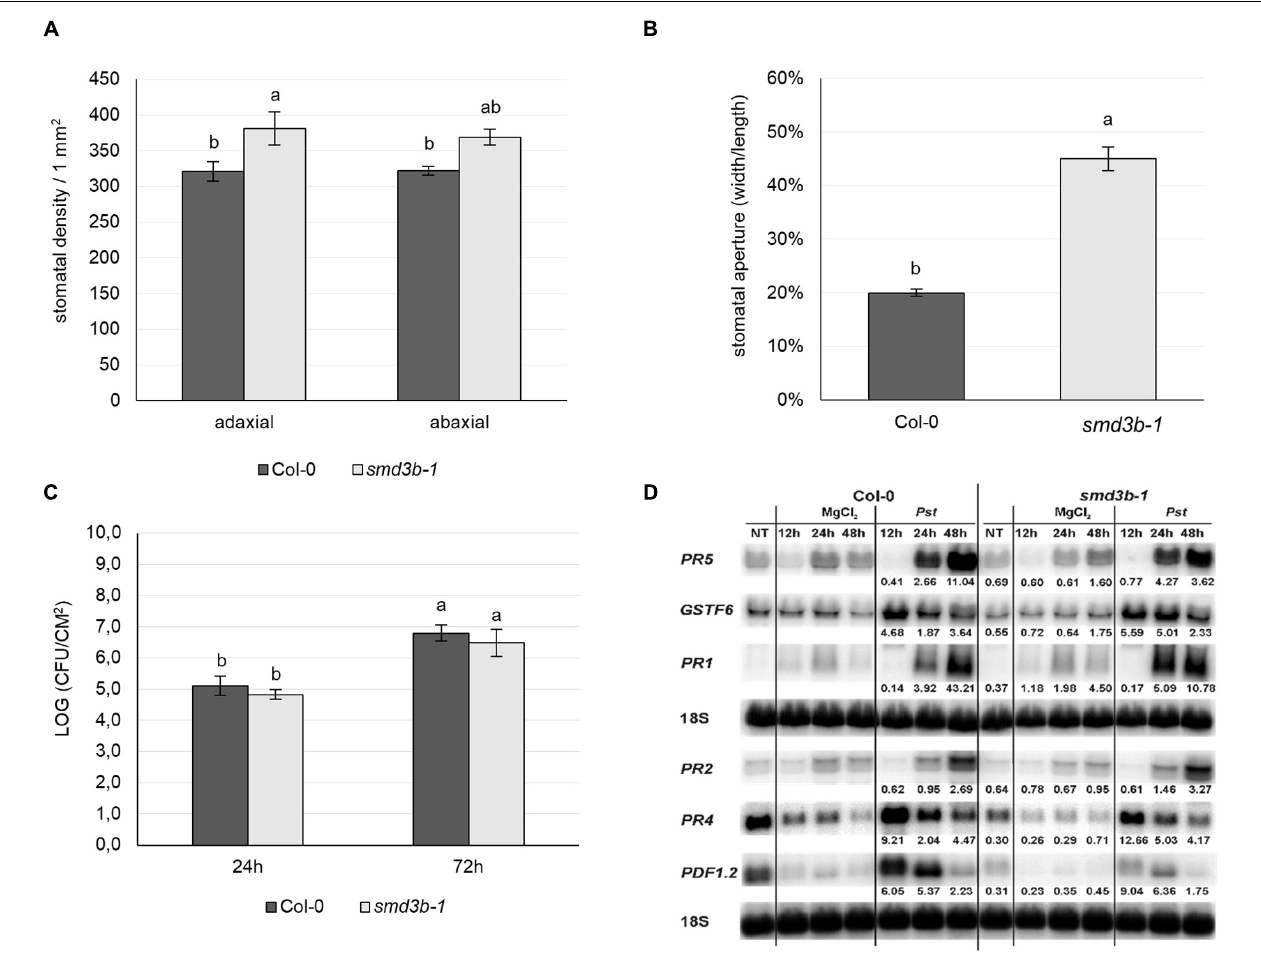
FIGURE 5 | SmD3 contributes to stomatal immunity. (A,B) Stomatal density and aperture of Col-0 and smd3b-1 plants. Comparison of the stomatal density on the abaxial and adaxial leaf side of Col-0 and smd3b-1 , shown as number of stomata per 1 mm 2 of leaf surface (A) . Stomatal aperture in Col-0 and smd3b-1 (B) . The aperture on the abaxial leaf side was calculated as stomata width to length to ratio and expressed as percentage. (C) The smd3b-1 mutant is not sensitive to Pst after infiltration inoculation. Growth of Pst DC3000 at 24 and 72 hpi after syringe infiltration in Col-0 and the smd3b-1 mutant. For each time point leaf disks were collected from 8 plants. Results are mean of two independent experiments and error bars represent SD. (A–C) Letters represent significant difference ( P < 0.05) for Tukey’s HSD test. (D) Northern blot analysis of factors involved in pathogen response. Samples were collected from non-treated (NT), control (MgCl 2 ) and injected ( Pst ) Col-0 and smd3b-1 plants at indicated time points. Numbers represent transcript level in Pst -treated Col-0 and the smd3b-1 relative to control and normalized to 18S rRNA loading